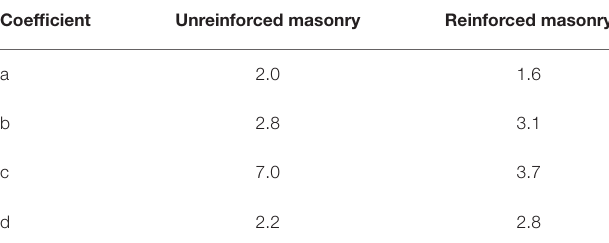
TABLE 6 | Terms of Equations (5) and (6).